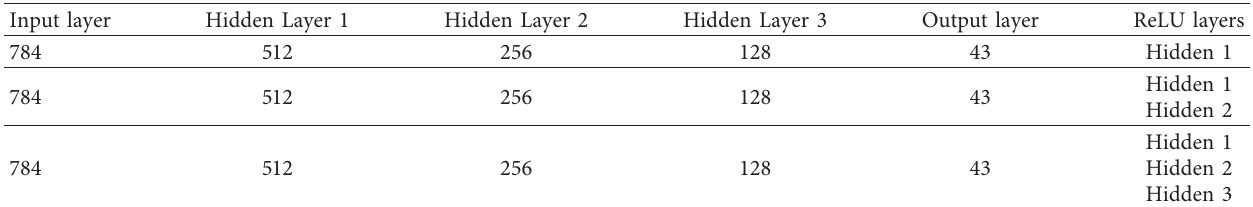
Table 1: Proposed